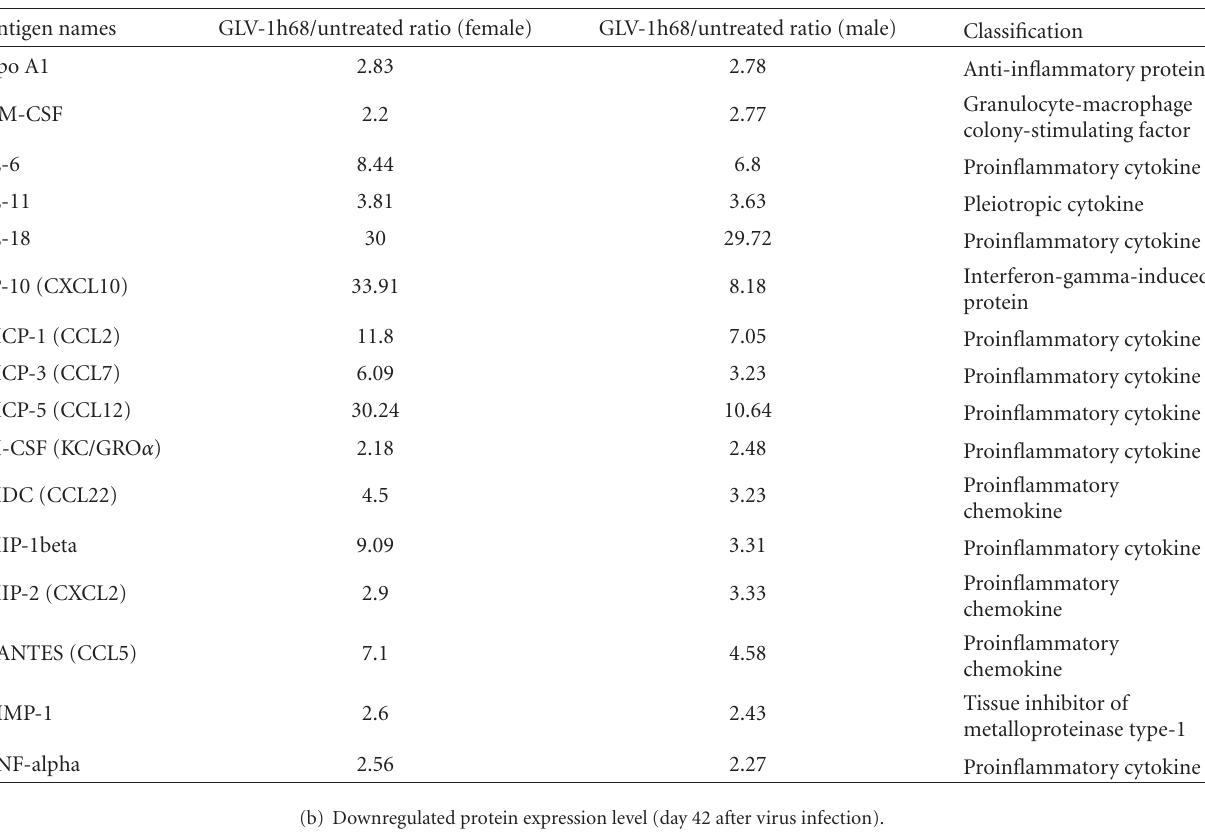
Table 2: Mouse immune-related protein antigen profiling in PC-3-derived tumors of male or female nude mice with or without GLV-1h68 treatment at the day 42 after virus infection ( n = 2). Folds of enhancement (a) or suppression (b) of mouse protein expression after virus injection are shown. Each value was determined as the mean of triplicate